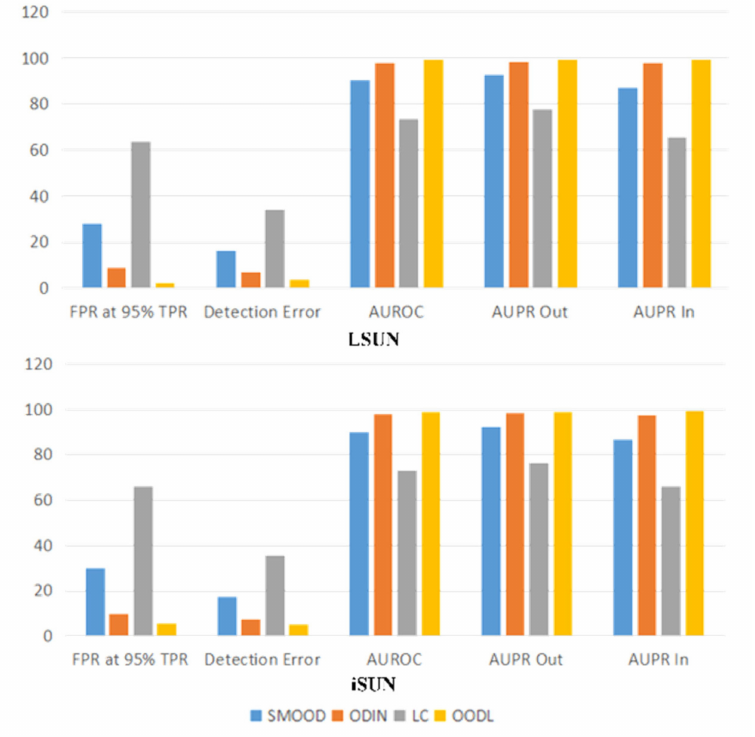
Figure 5. Comparison of results. The ID data are CIFAR-10, the OOD data are TinyImageNet, LSUN, and iSUN, and the model is Resnet.